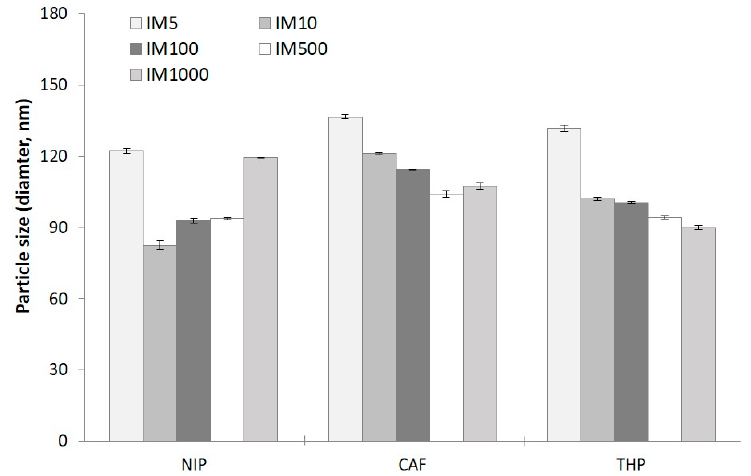
Figure 7. Hydrodynamic sizes, d H of microspheres synthesized at various I:tM ratios. Measurements were conducted using Dynamic Light scattering (DLS) and using ACN as the dispersant.